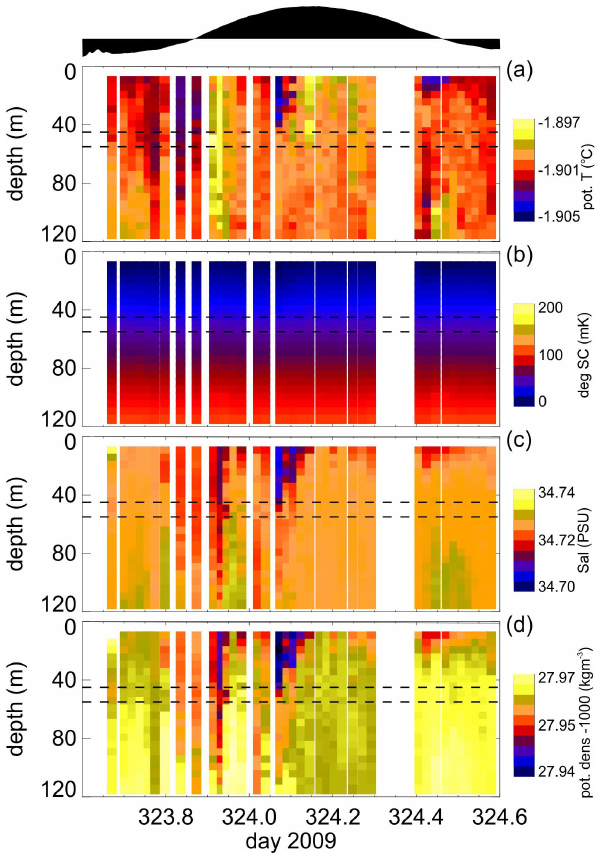
Fig. 7. CTD scalar data products as a function of time (NZST = UTC+12) showing (a) potential temperature, (b) degree of super- cooling (in situ temperature-local freezing temperature), (c) salinity and (d) potential density anomaly. The approximate local depth range of the glacier is shown as horizontal dashed lines. The tidal elevation is shown not to scale above panel (a)